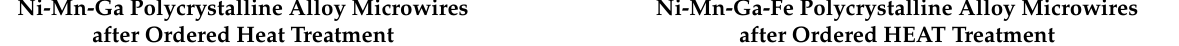
after Ordered Heat